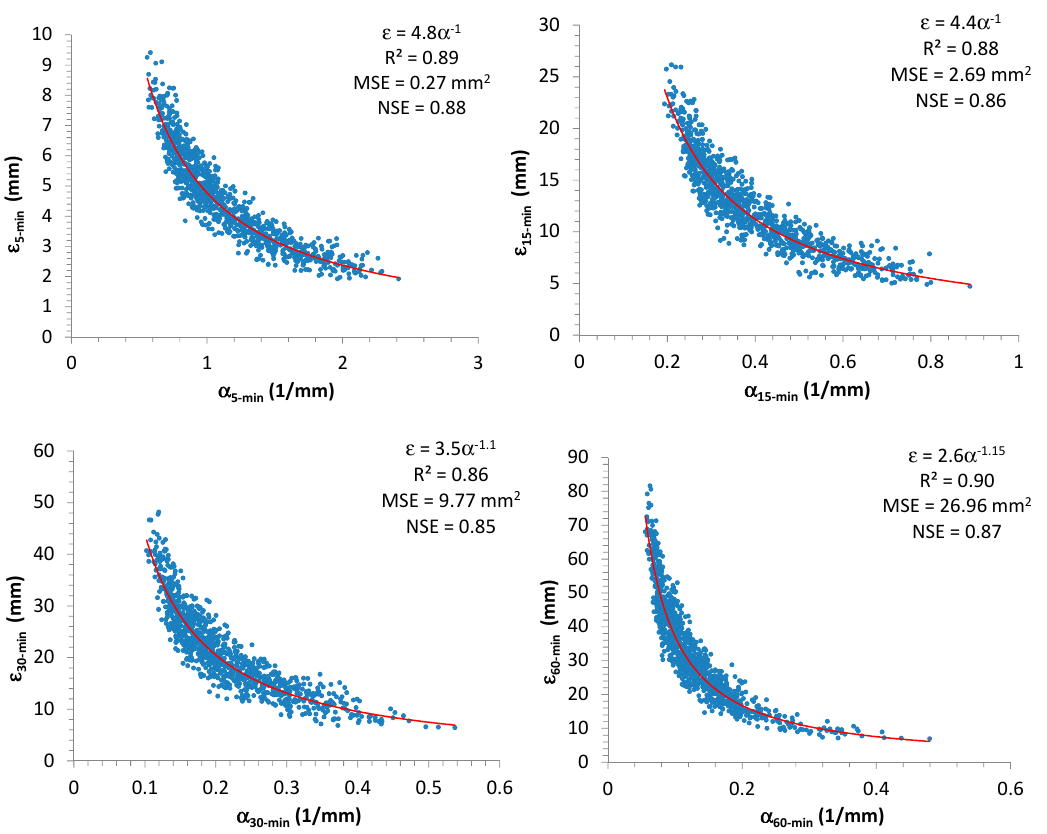
Figure 2. Scatter plots for estimated EV1 parameters α and ε , related to annual maximal rainfall (AMR) data, which were obtained from 500-year NSRP time series with a resolution of 1 min.